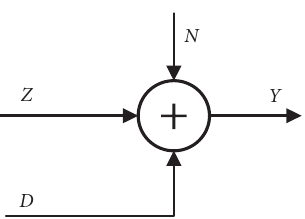
Figure 10: Channel of additive Gaussian noise and signal-dependent clutter. Table 6: Some parameters corresponding to different optimal